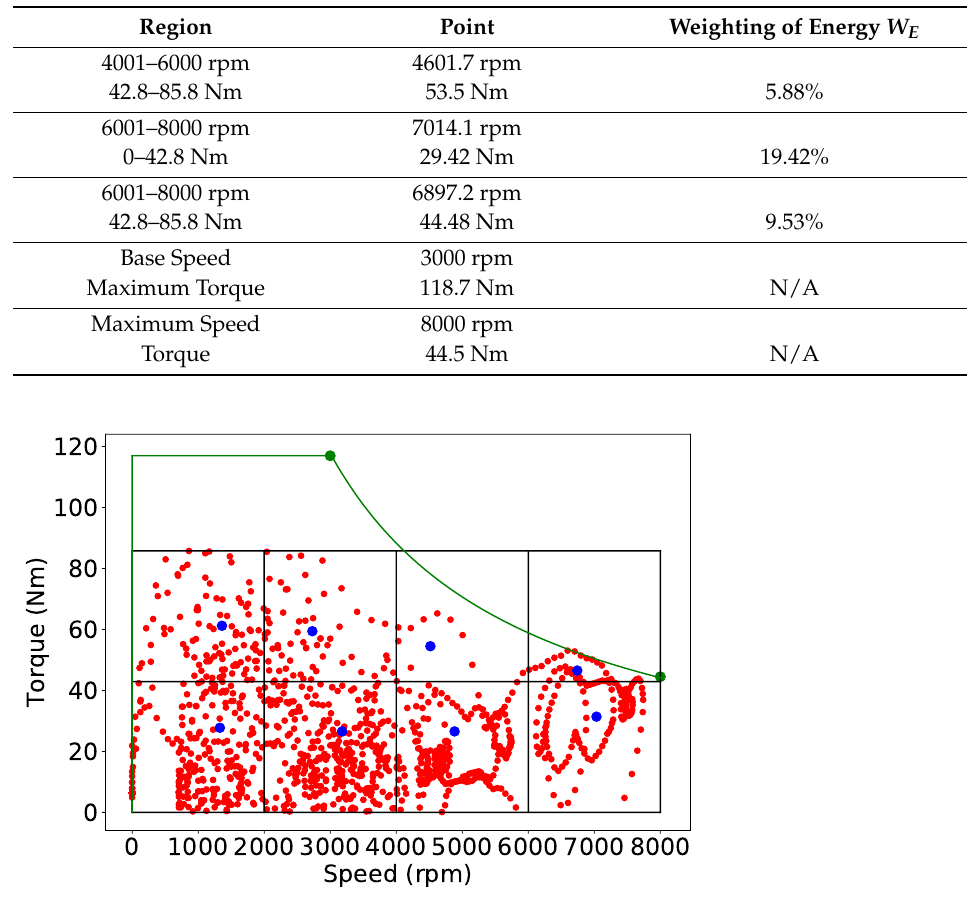
Figure 6. Representative points from ECG. Table 3. Specifications of proposed motor